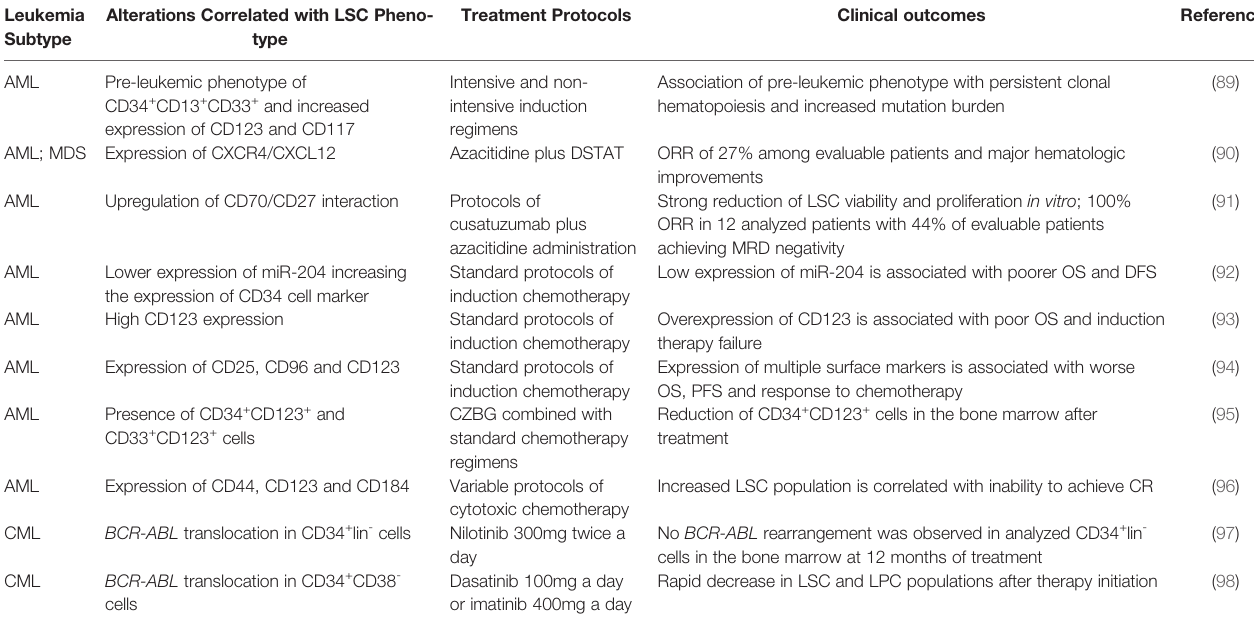
TABLE 1 | Studies of the past 10 years indicating biomarkers for stem cells and “ stemness ” properties in leukemia and the respective prognostic relevance after